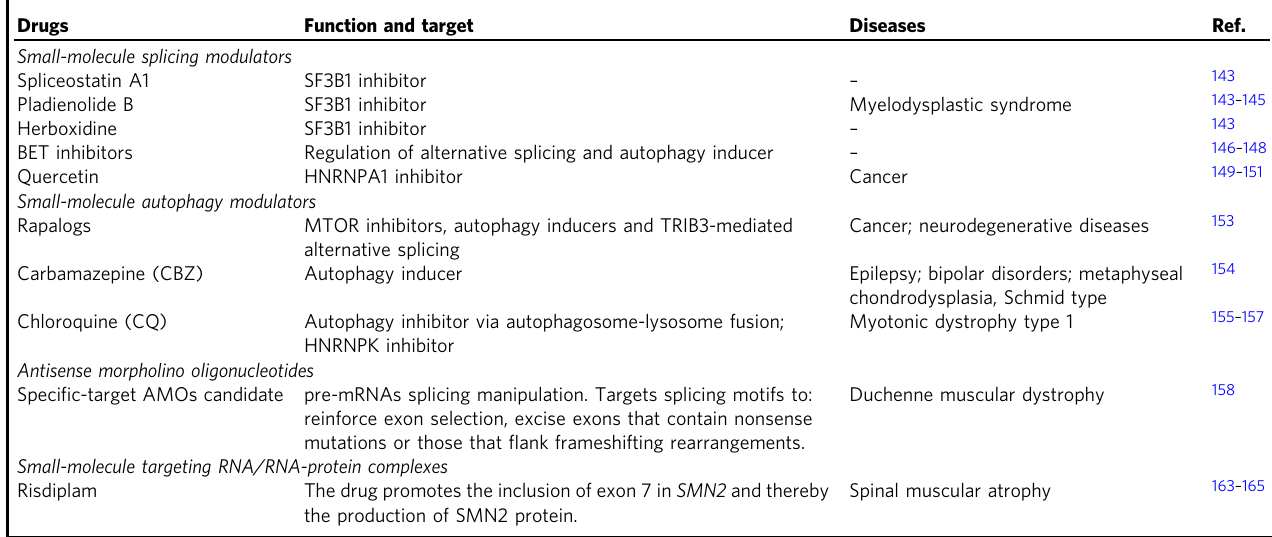
Table 1 Drugs used to target alternative splicing and impacts on